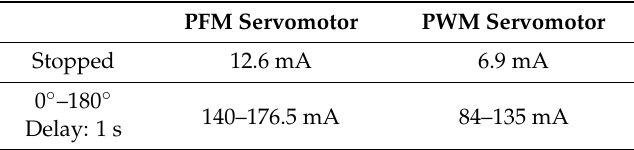
Table 1. Current consumption of the PWM and PFM servomotors.